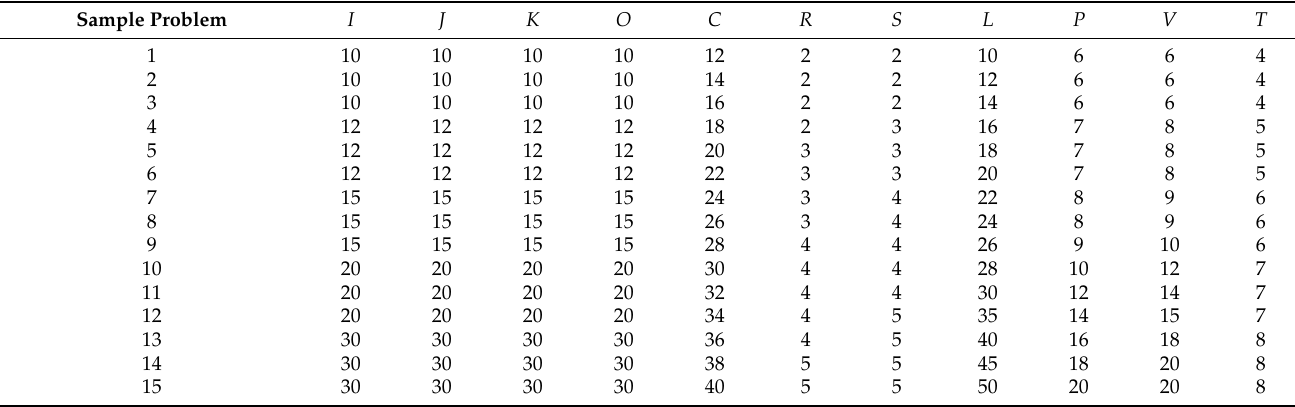
Table 11. Large-size sample